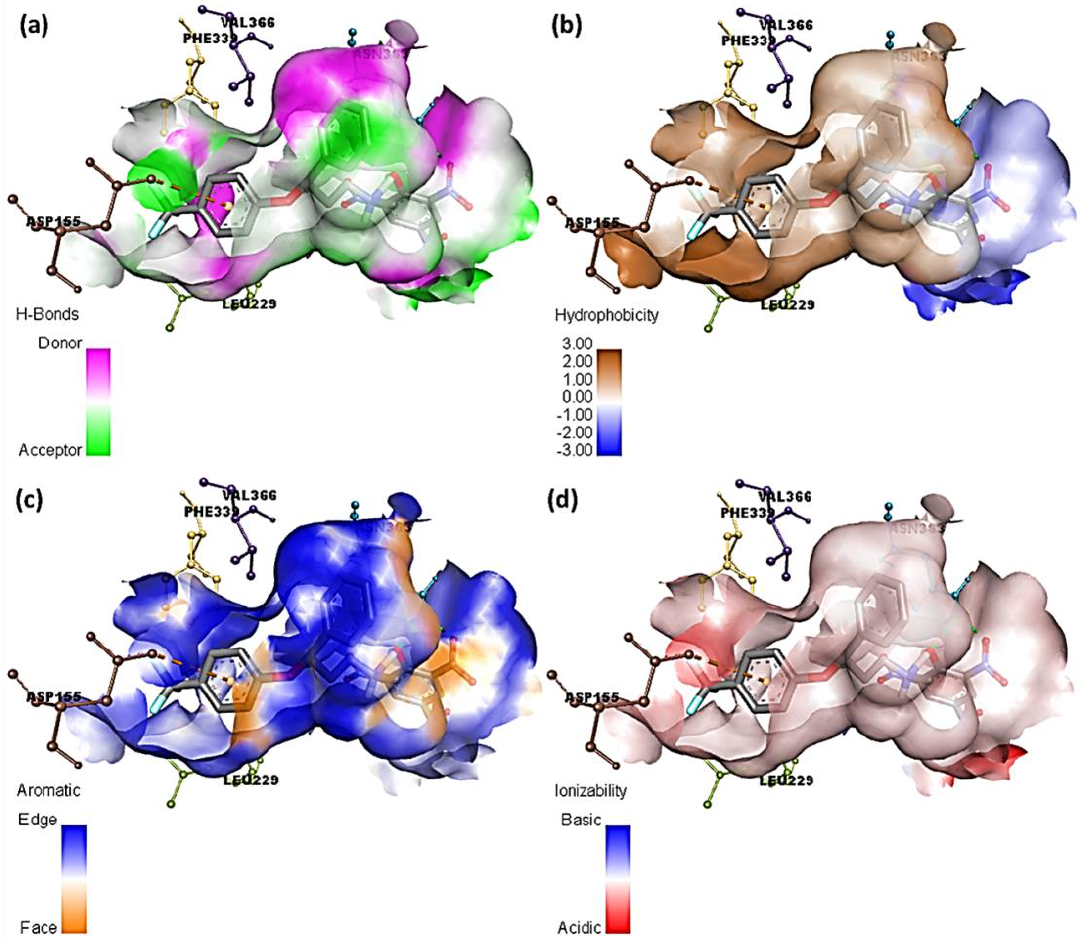
Figure 8. Molecular docking data of [(FXN)(PA)]–serotonin complex; ( a ) bonding surface of hydrogen bonds, ( b ) hydrophobic surfaces, ( c ) aromatic surface, and ( d ) ionizability surface.